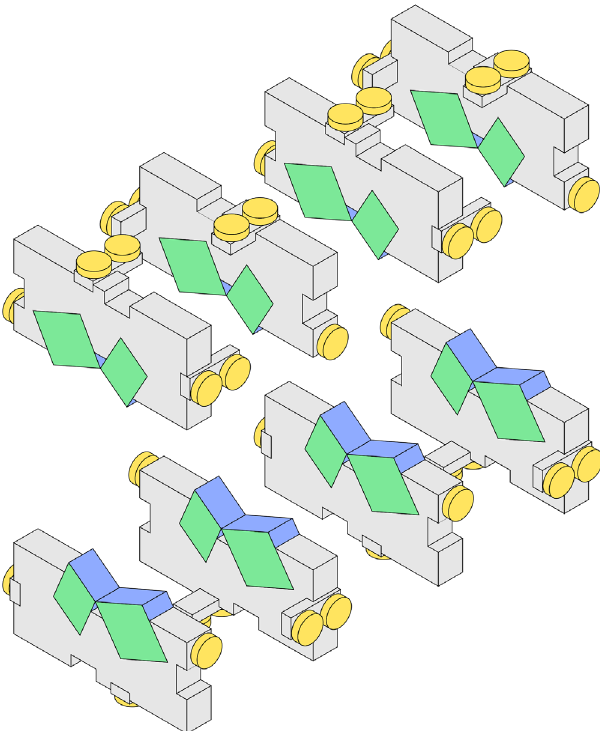
FIG. 3. Movable units (bearings are yellow, magnets — blue, poles — green).